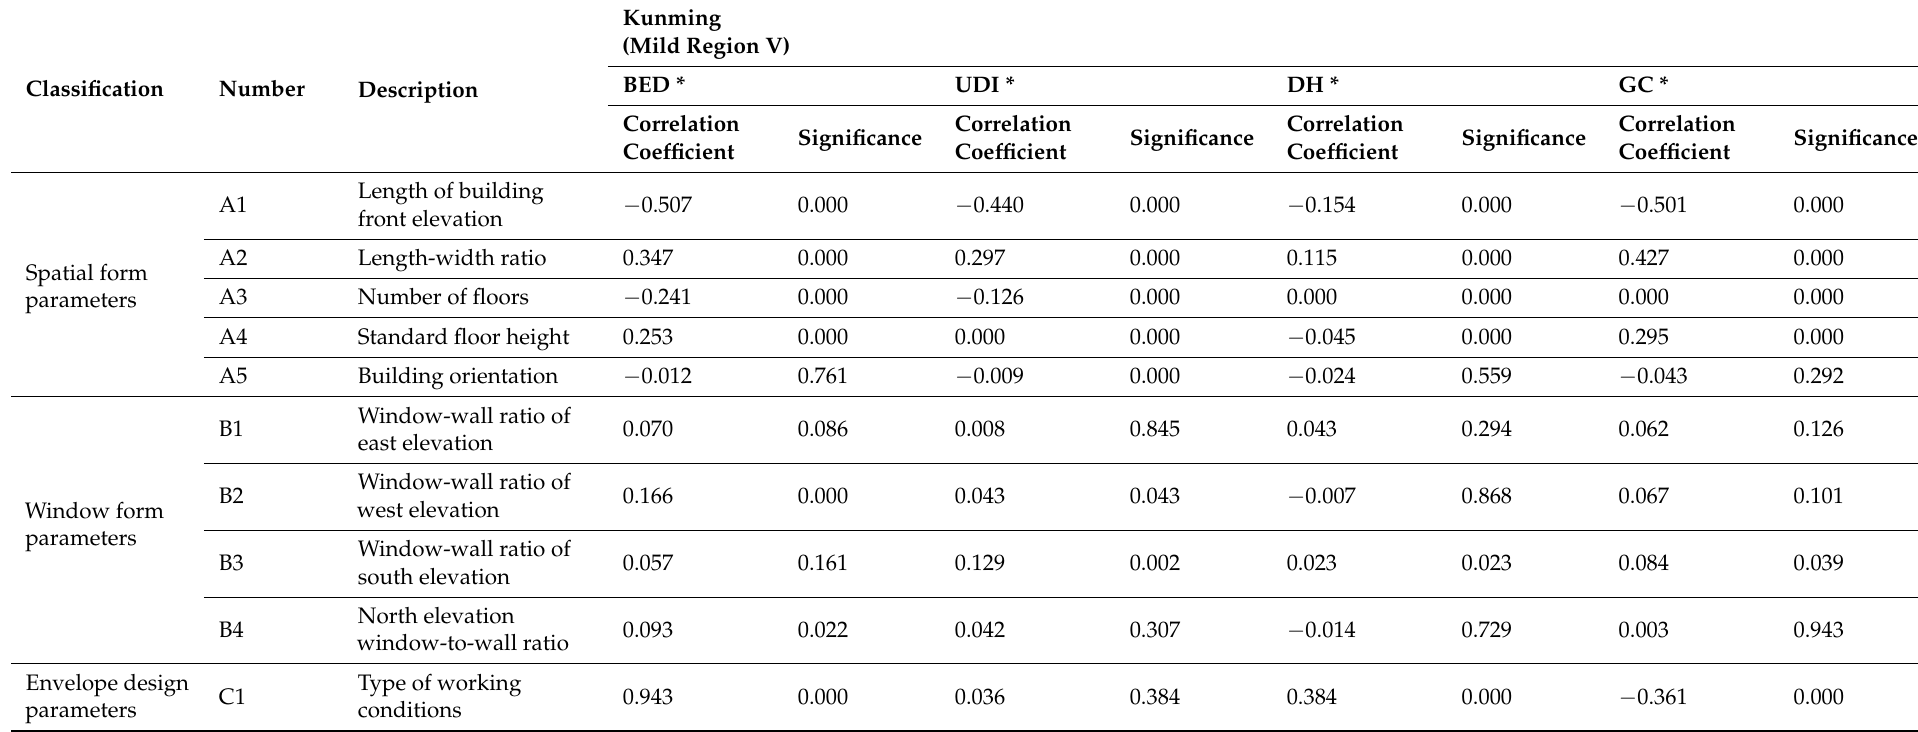
Table 12. Comparison of Spearman’s rank correlation coefficient of the design parameters of building forms in